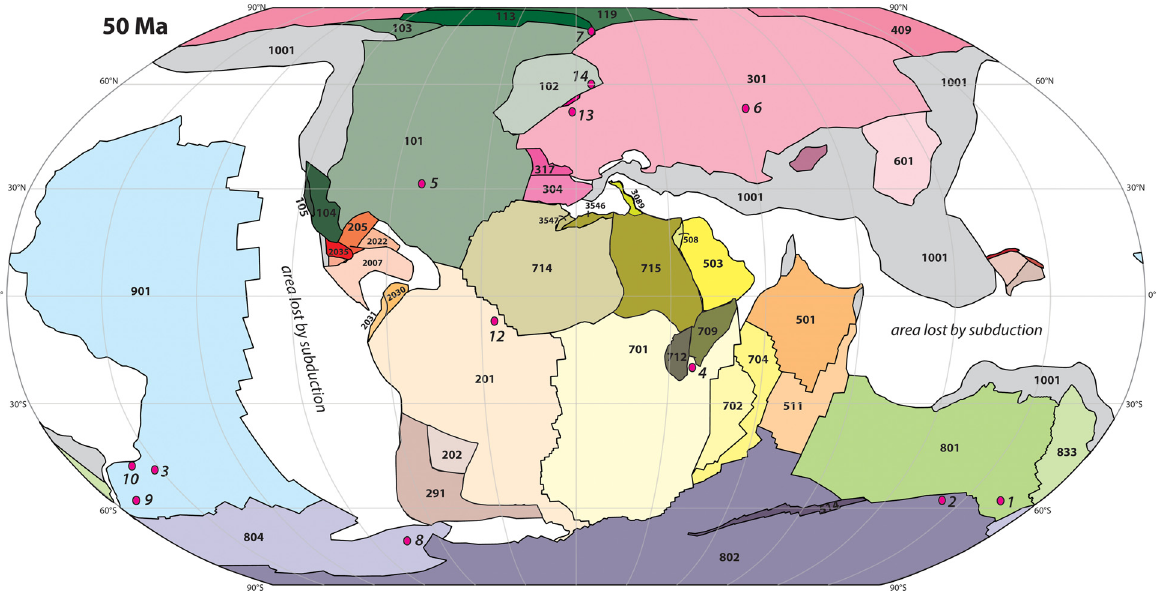
Fig 4. Plate reconstruction at 50 Ma, around the moment of the Early Eocene Climate Optimum, with the sites used for sea surface temperature estimates in Figs 1 and 5. Reconstruction made in GPlates from Seton and colleagues [14], with modifications as indicated in the main text, placed in the paleomagnetic reference frame of Torsvik and colleagues [20]. Absolute paleolongitude of the global plate motion chain is unconstrained, and irrelevant for paleoclimate reconstructions. Meridians are spaced with 30 degree intervals. Italic numbers 1 – 14 indicate the reconstructed locations of the sites used for a case study on Eocene meridional temperature, see Fig 5, and Table